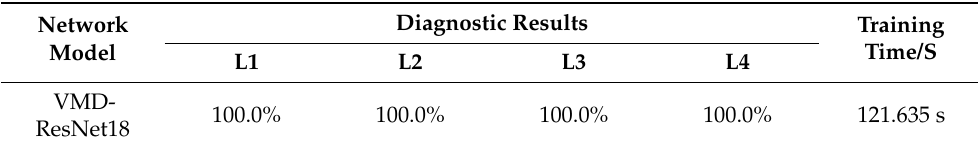
Table 7. The pre-training diagnostic results of the VMD-ResNet18.